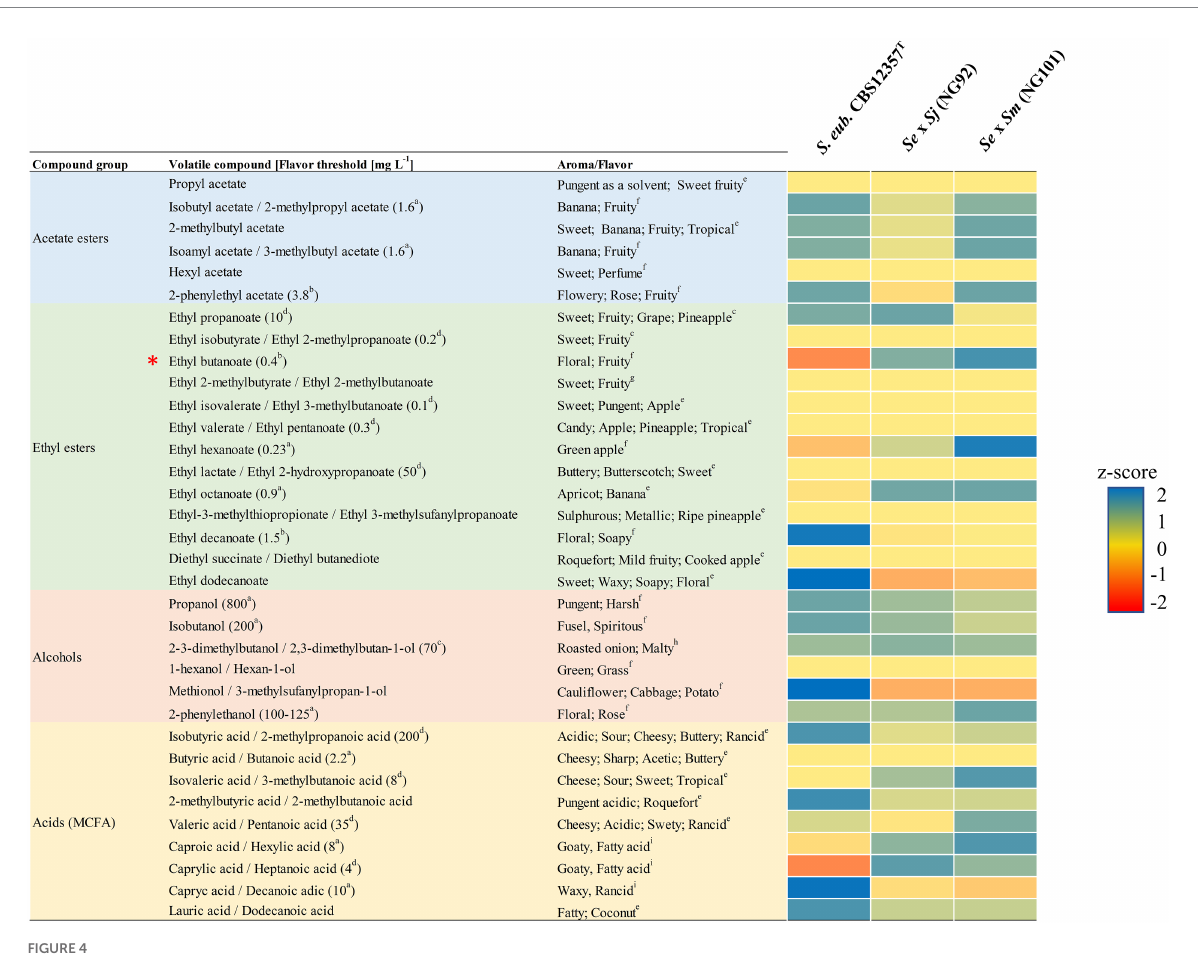
FIGURE 4 Comparative analysis of aroma production by the generated de novo hybrids NG92 ( S. eubayanus CBS 12357 T × S. jurei D5095 T / Se × Sj ) and NG101 ( S. eubayanus CBS 12357 T × S. mikatae NBRC 10997/ Se × Sm ) and their common parental strain S. eubayanus CBS 12357 T . Colors show the range of the calculated Z -scores per aroma compound indicating production values above average, average, and below average shown with blue, yellow, and red, respectively. The aroma compounds are grouped by acetate esters, ethyl esters, alcohols, and acids (medium-chain fatty acids/ MCFA). Flavor thresholds in beer values (shown in brackets) were obtained from Meilgaard (1982) ( a ); Meilgaard (1975a) ( b ); Meilgaard (1975b) ( c ); Harrison (1970) ( d ). Corresponding aromas/flavors for each volatile compound tested were obtained from The Good Scent Company Information System (2022) ( e ); Swiegers et al. (2005) ( f ); PubChem (2022) ( g ); Dunlevy et al. (2009) ( h ); Blanco et al. (2016) ( i ). The calculations are based on aroma compound concentrations [mg L − 1 ] from triplicate biological fermentations with high reproducibility including values below and above the sensitivity of the GC/MS analysis. Detailed quantitative data of the aroma compounds with standard deviation of all strains including the aroma profile of the reference S. pastorianus CBS 1513 strain are presented in Supplementary Table S9. Z-scores generated from concentrations below or just above the threshold of measurement are marked with an asterisk